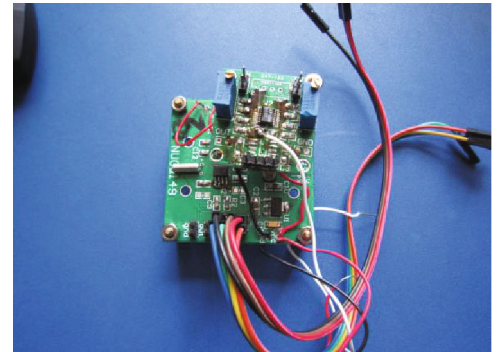
Figure 26: Signal conditioning circuit. Table 10: The experimental data of wind tunnel.